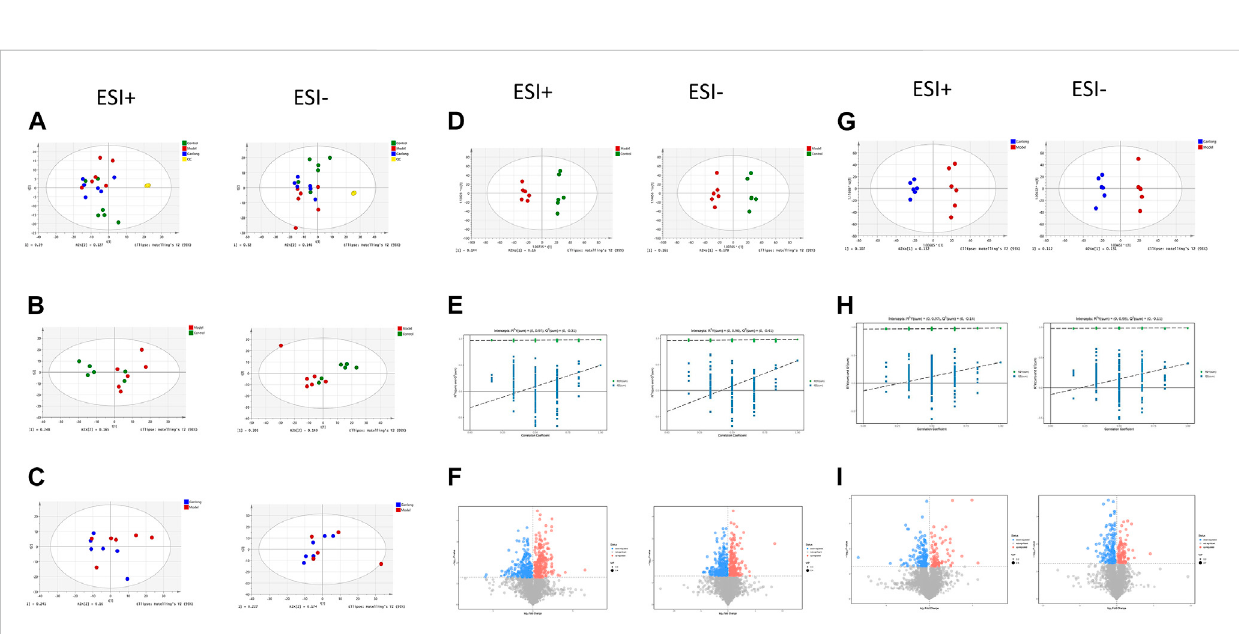
FIGURE 7 SerummetabolomicanalysisofGanlongcapsuleonliver fi brosisinrats. (A) PlotsoflivertissuePCAscoresbetweenpositiveandnegativeionnormal controlgroup,ganlongcapsulegroupandmodelgrouprats. (B) PCAplotsoflivertissuesbetweenmodelgroupvs.normalcontrolgroupand (C) Ganlong capsule group vs. model group rats in positive and negative ion mode. (D – F) Plots of OPLS-DA scores, 200th response ranking test plots and volcano plots between normal control and model groups in positive and negative ion mode. (G – I) Plots of OPLS-DA scores, 200 response sorting test plots and volcanoes between the model and ganlong capsule groups in positive and negative ion mode. Control group, model group and ganlong capsule treated group ( n = 6).